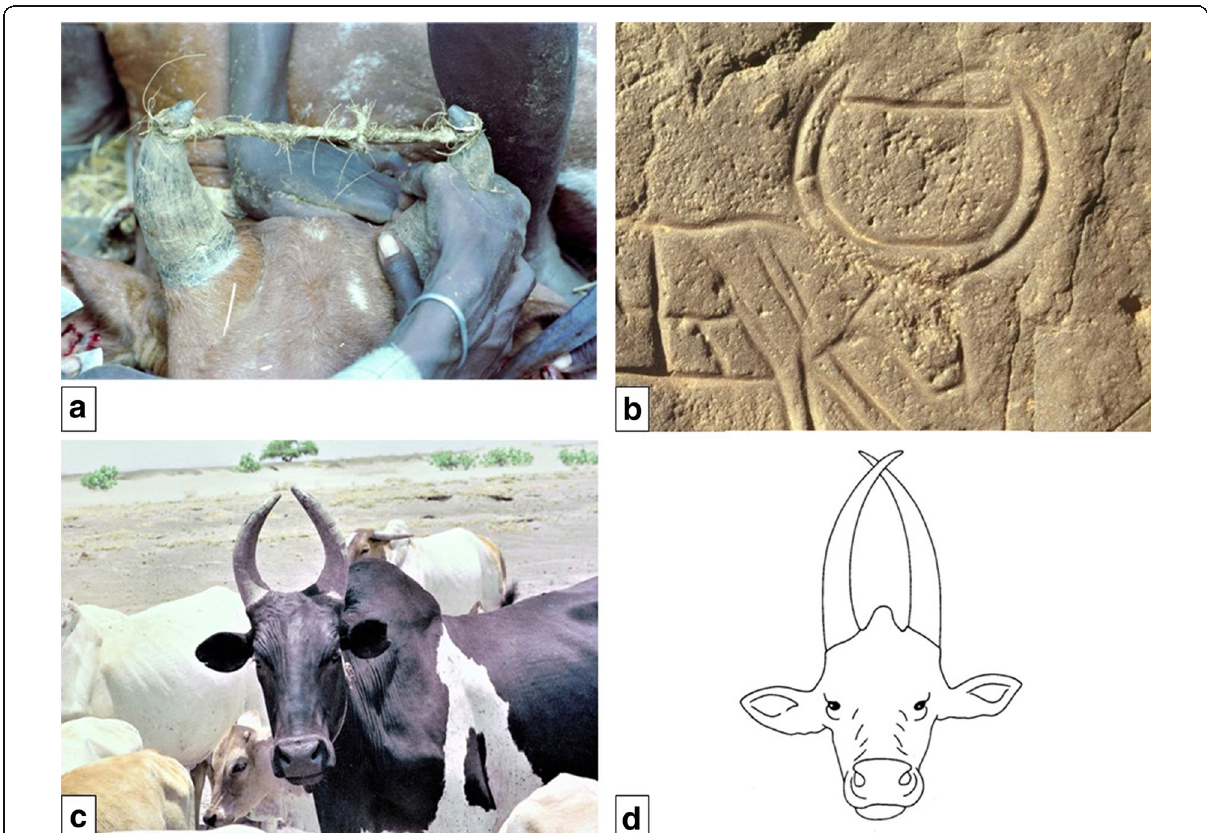
Fig. 5 Horn deformation: a live ox just after the procedure of “ vertical horn deformation ” : the horn bone cores have been broken, the horn sheath smove upright and close to each other and are fixed in such a position with a rope between the horn tips. Lotikipi Plain. b A depiction of a similar technique in the rock art of Wadi Mathendous area, Libya, approx 7000 to 6000 BC (David Coulson, Trust for African Rock Art). c An adult ox with horns growing according to the vertical horn deformation. d Interpretation of a cattle skull remains found at a cattle bucrania in Kerma, Sudan (Chaix and Hansen 2003, Chaix et al.